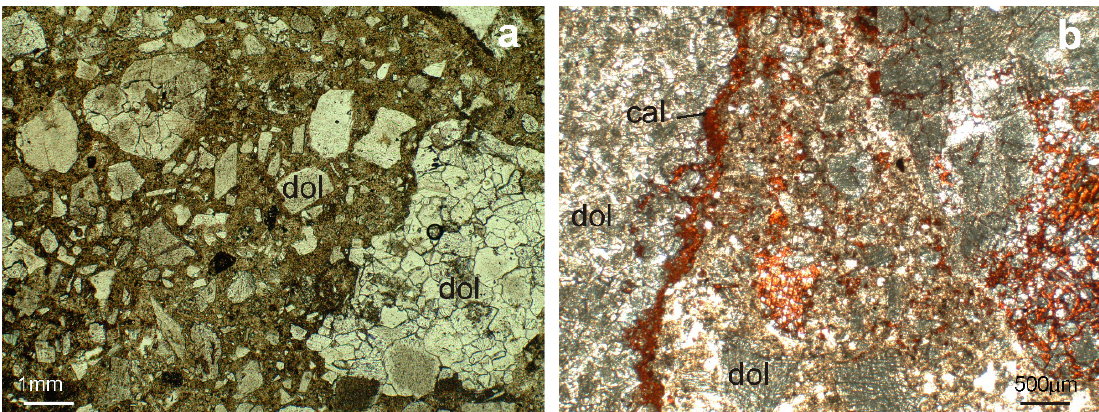
Figure 5. Microscope image of the Camarasa type A concrete. ( a ) General view; ( b ) sample stained with red alizarin that shows a red rim of calcite in the contact dolomite aggregate-paste. dol, dolomite; cal, calcite.